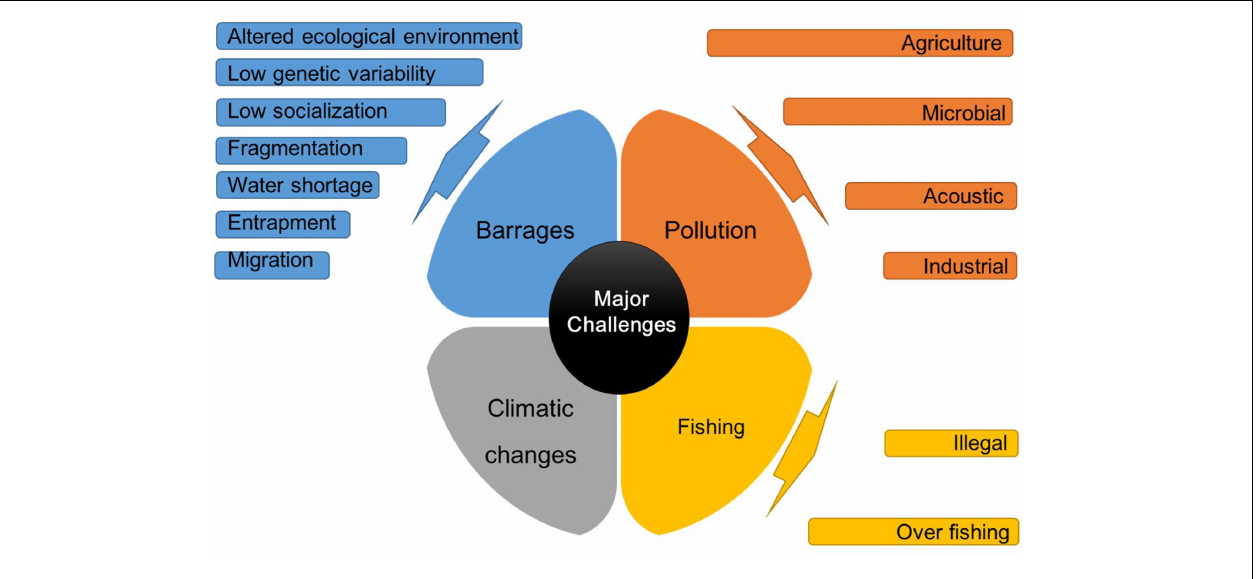
FIGURE 1 | Summary of the major challenges to Indus River